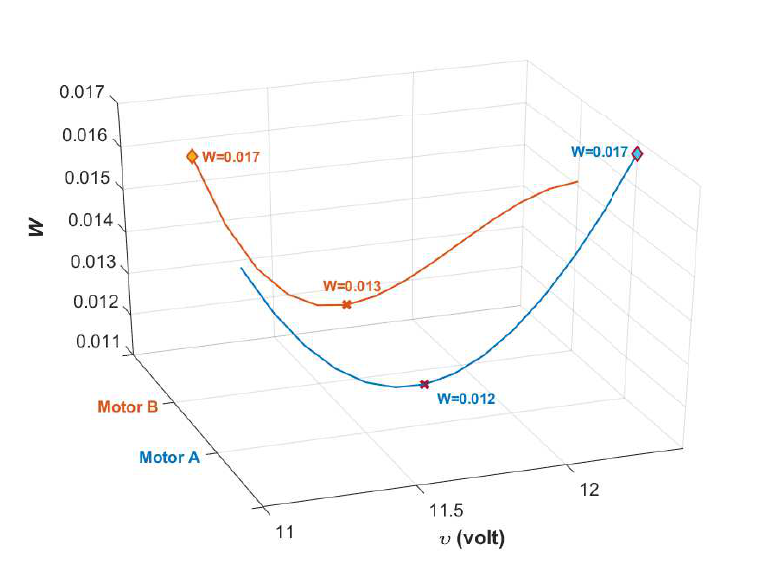
Figure 16. Variation of W against υ from υ min = 11.1 volts until υ max = 12.4 volts. The plots show that W ∈ [ 0.012,0.017 ] for Motor A and W ∈ [ 0.013,0.017 ] for Motor